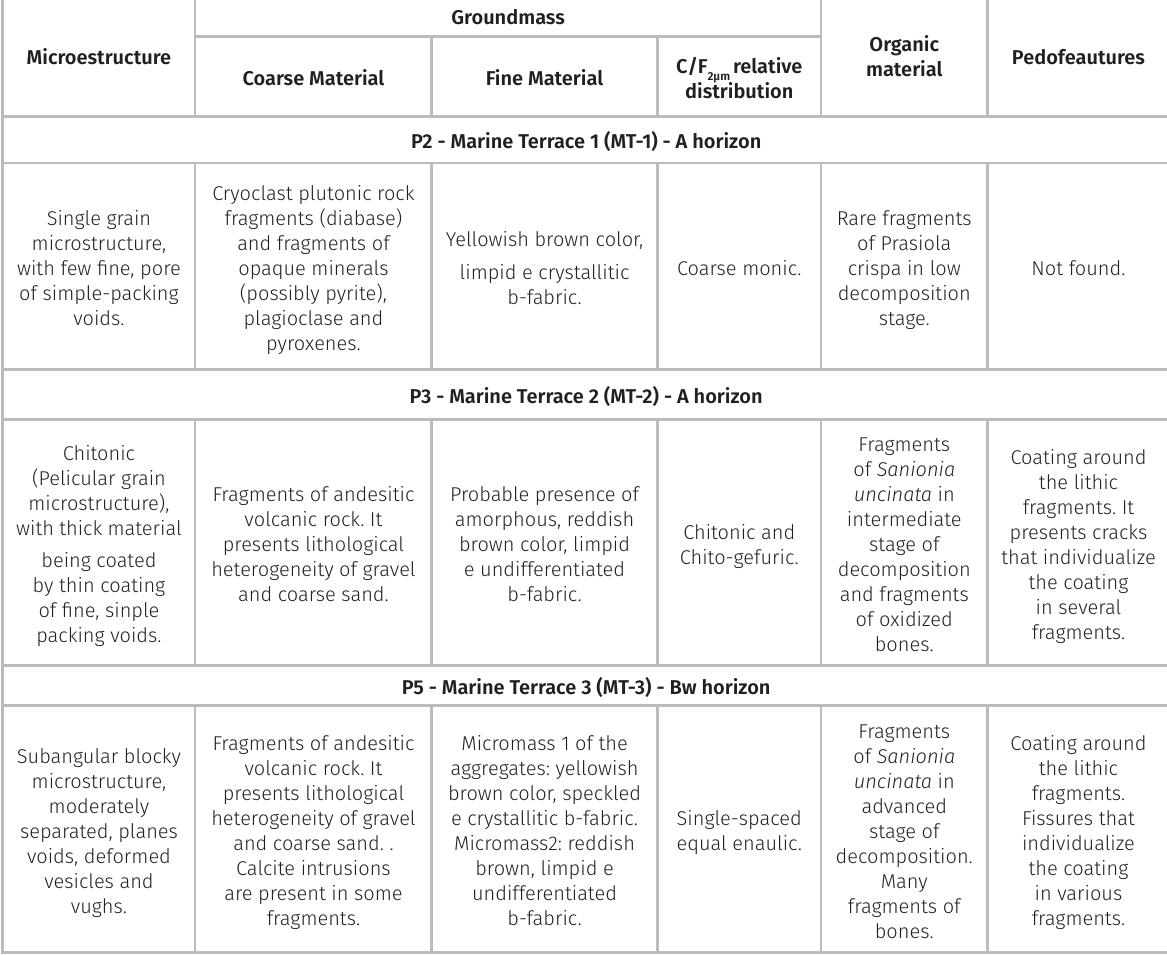
Table V. Micromorphological properties of the soils from HP marine terraces.